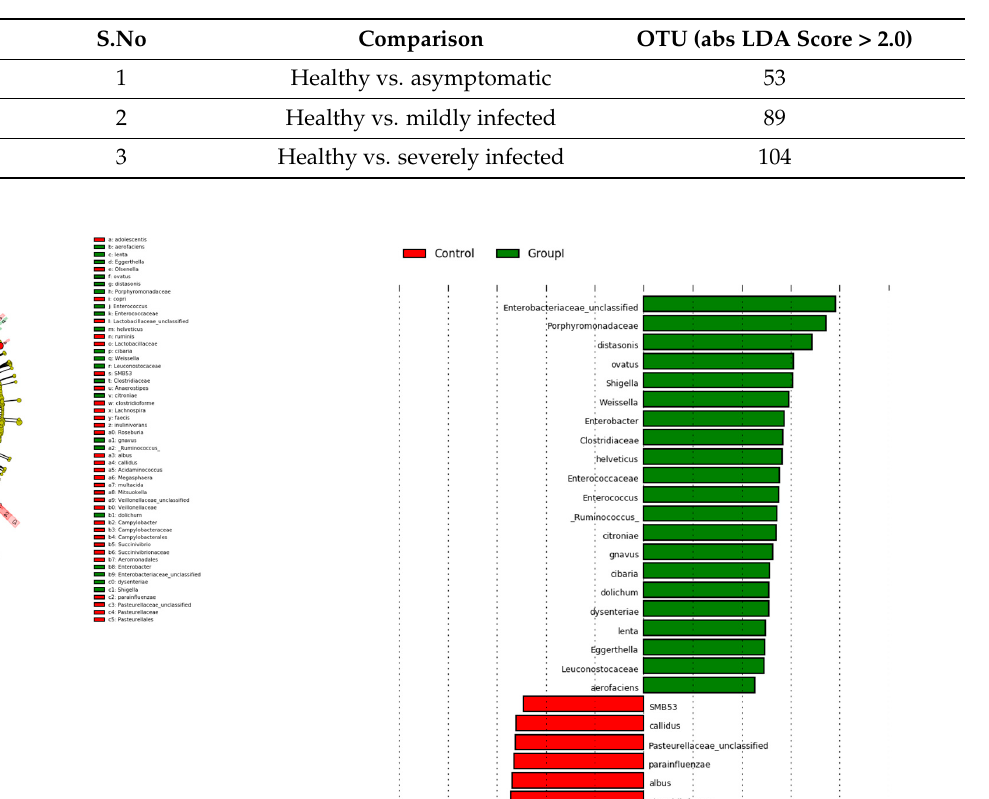
Table 2. Changes in the relative operational taxonomic units of the gut microbiota.